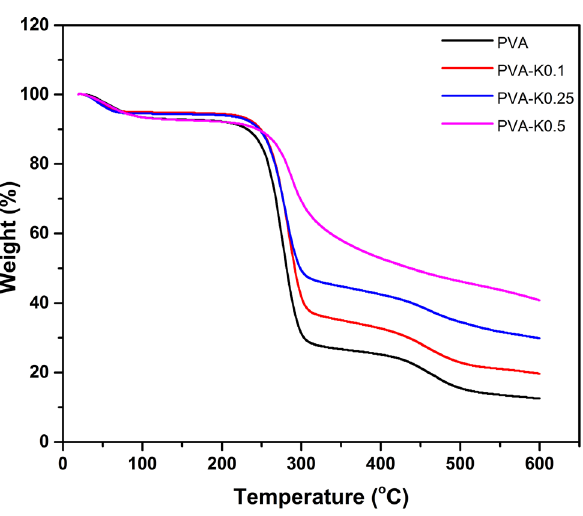
Figure 1. FT-IR spectra of PVA hydrogel membrane and PVA/Kaolin composite hydrogel membranes.